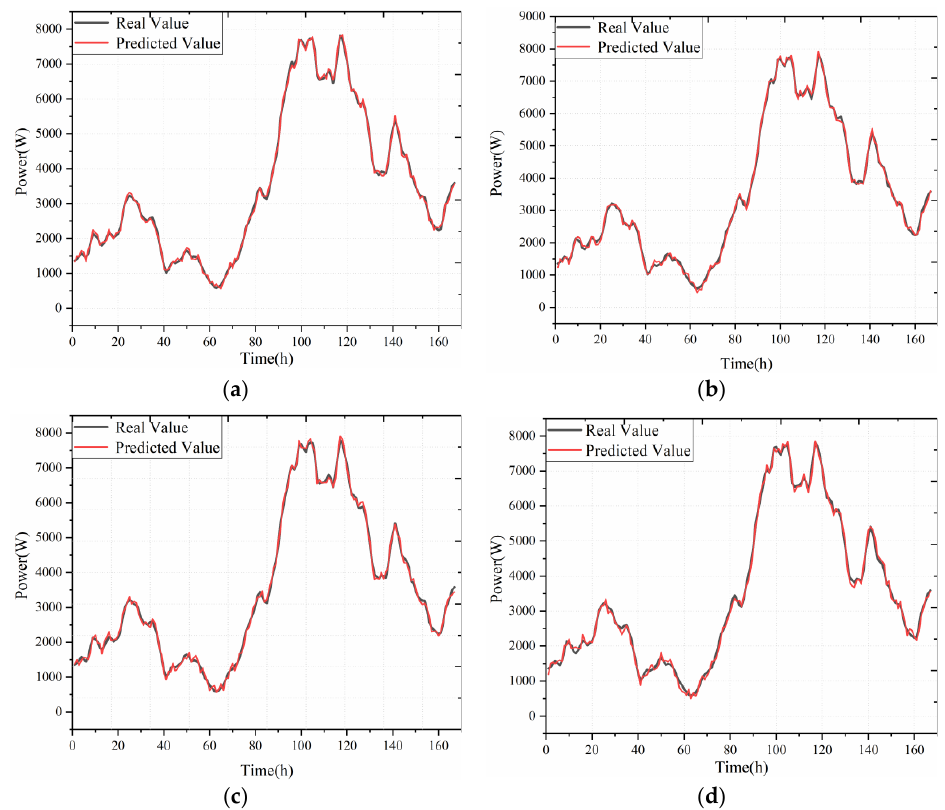
Figure 7. Model prediction results: ( a ) VMD-TCN; ( b ) VMD-LSTM; ( c ) TCN; ( d ) LSTM.